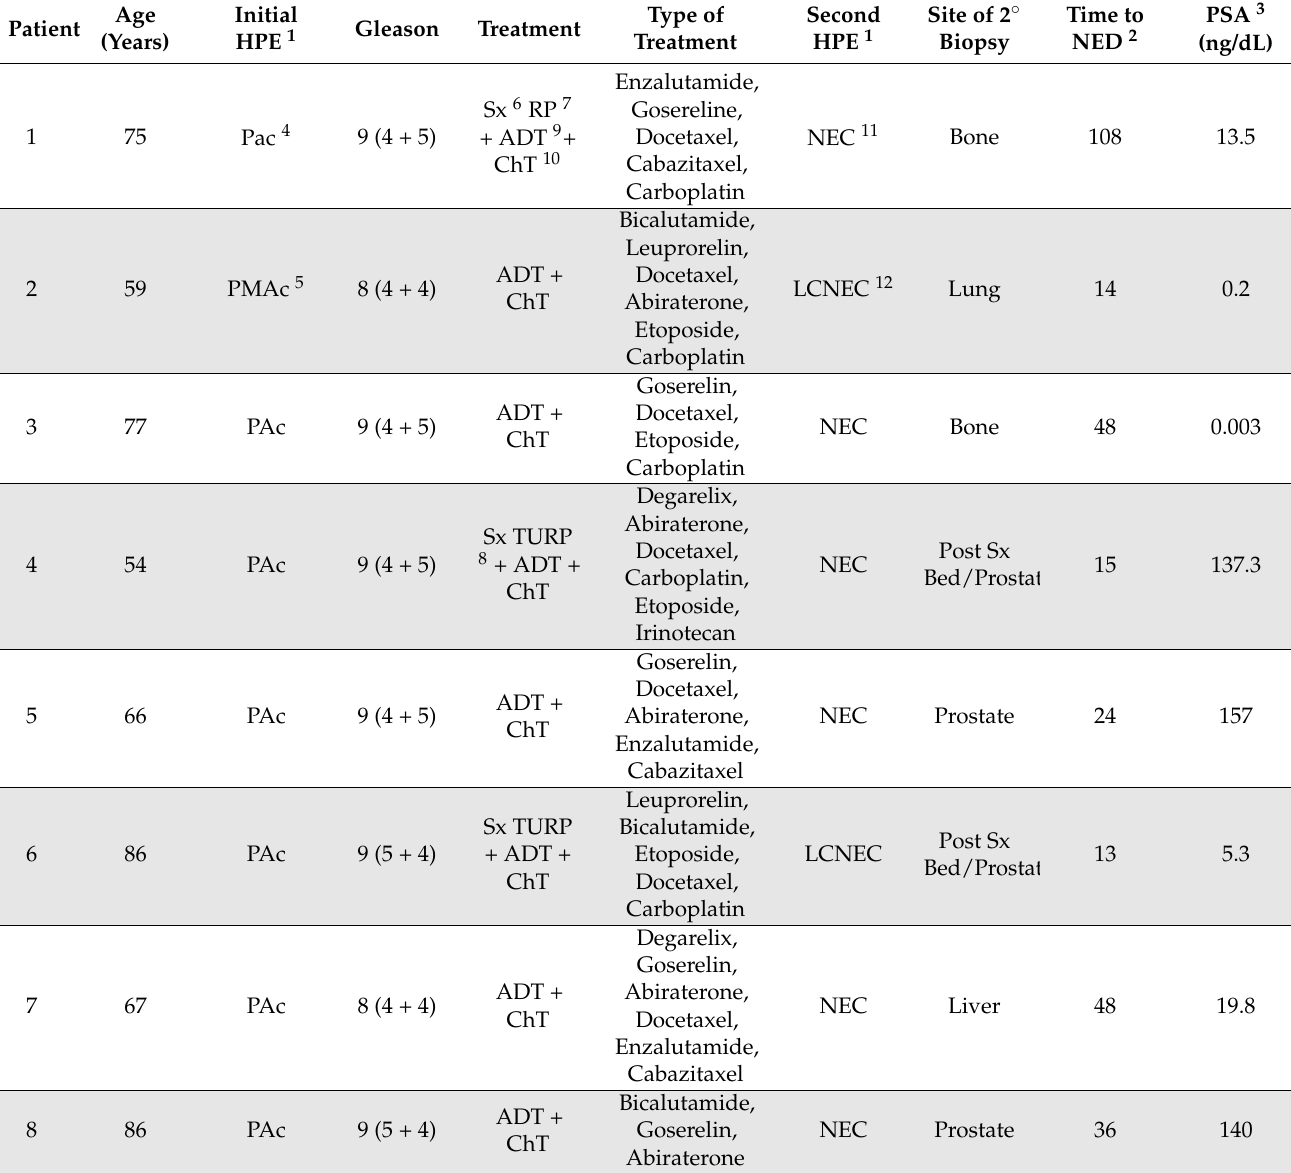
Table 1. General characteristics of the